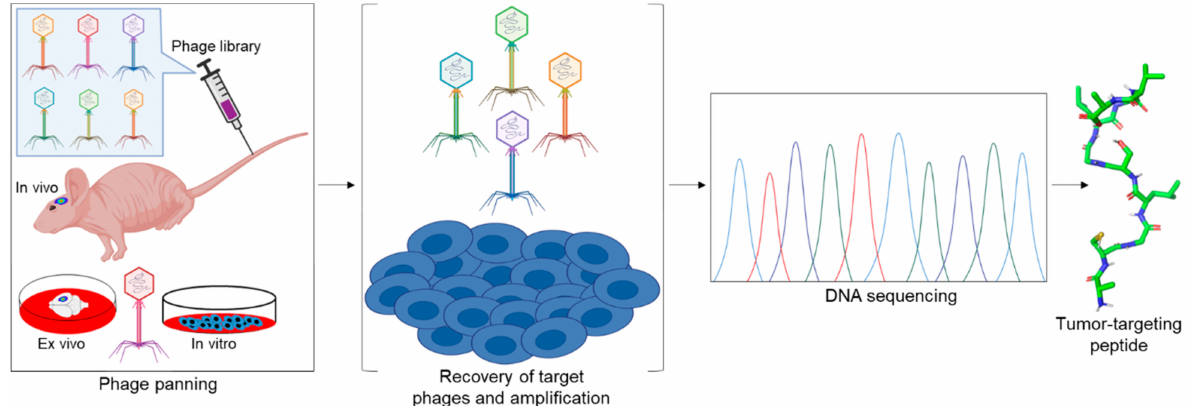
Figure 1. Schematic representation of phage display. In vivo, ex vivo, and in vitro biopanning of phage displayed peptide libraries, recovery of target phage, phage amplification, sequencing, and identification of tumor-targeting peptides. The figure was created with BioRender.com (access on 28 February 2021). The tumor-targeting peptide was generated from an unpublished data using discovery studio visualizer v19.1.0.18287 (BIOVIA).